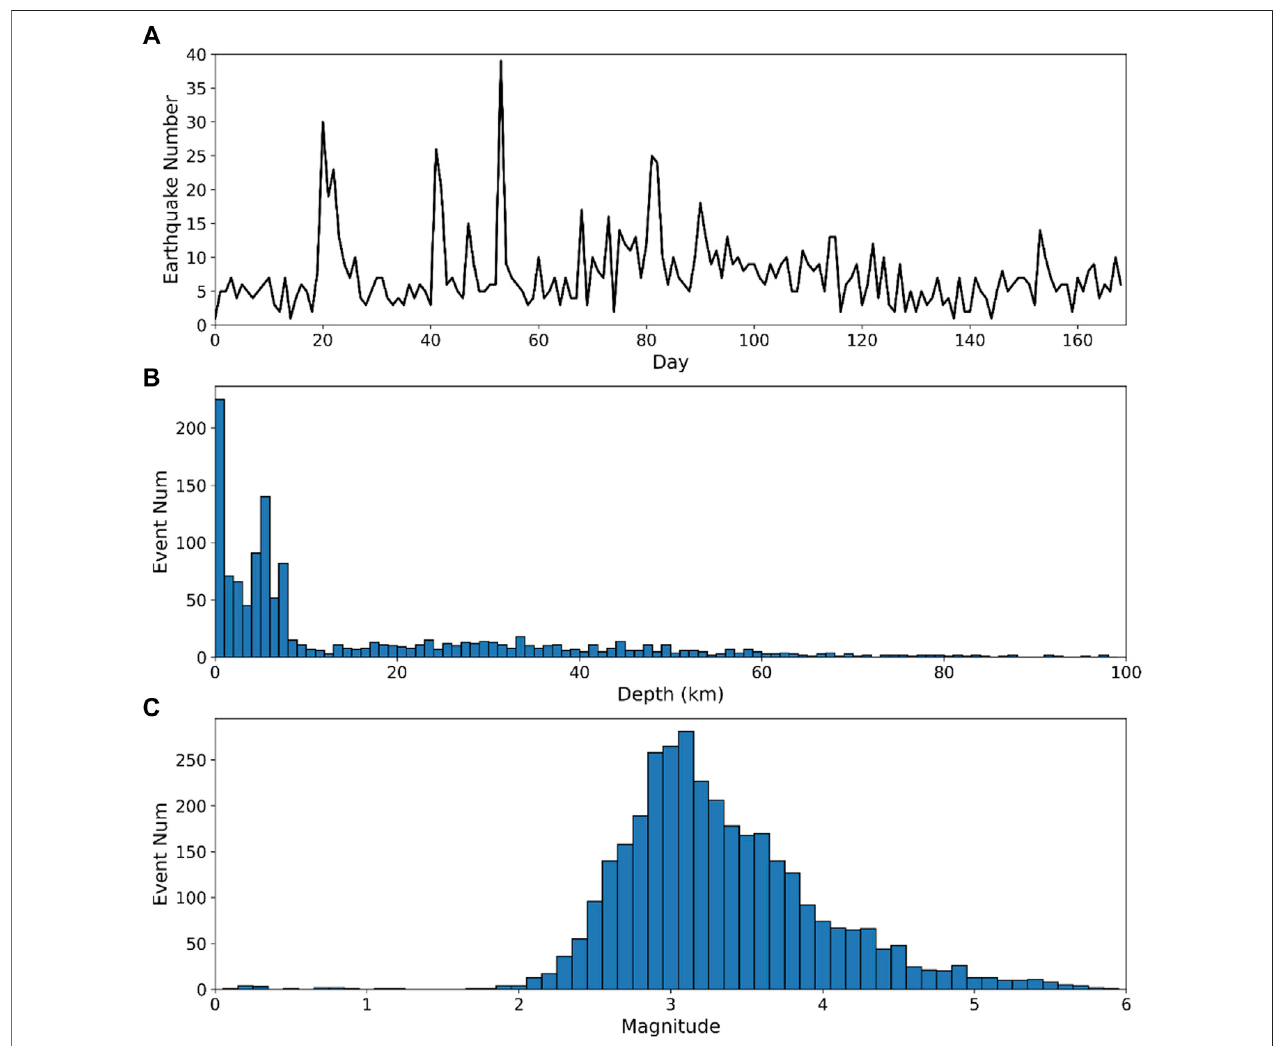
FIGURE 6 | (A) Daily occurrence times of earthquakes. (The fi rst day of the record date is 16 December) (B) The depth distribution. (C) Magnitudes.